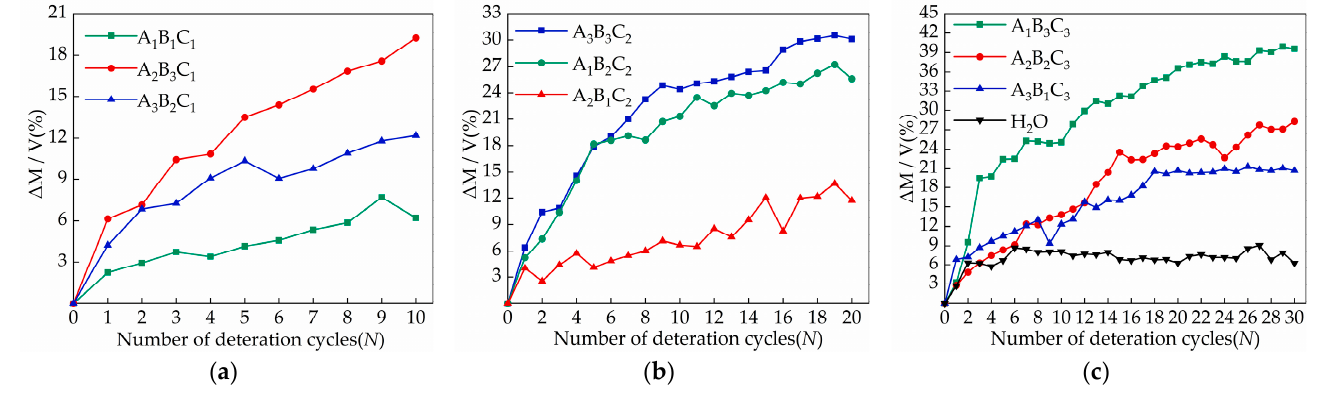
Figure 4. The influence curve of different salt content and cycle times on sample quality: ( a ) A 1 B 1 C 1 , A 2 B 3 C 1 , A 3 B 2 C 1 ; ( b ) A 3 B 3 C 2 , A 1 B 2 C 2 , A 2 B 1 C 2 ;( c ) A 1 B 3 C 3 , A 2 B 2 C 3 , A 3 B 1 C 3 , H 2 O control group.